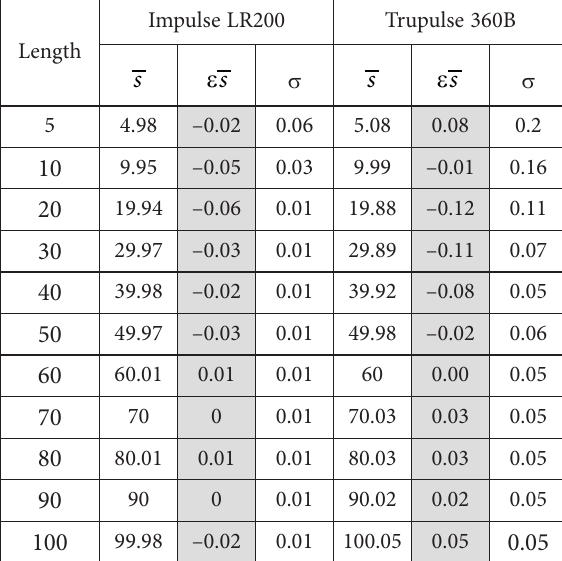
Table 1. Average values, average value errors and standard deviation of obtained lengths according to used device [m]